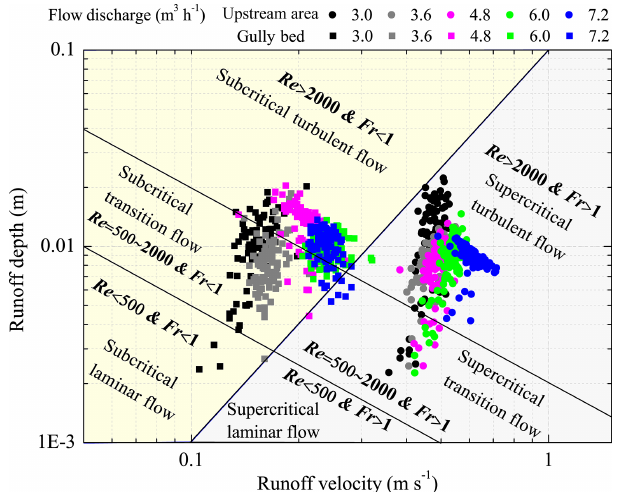
Figure 6. Runoff regime zones of upstream area and gully bed un- der different inflow discharge